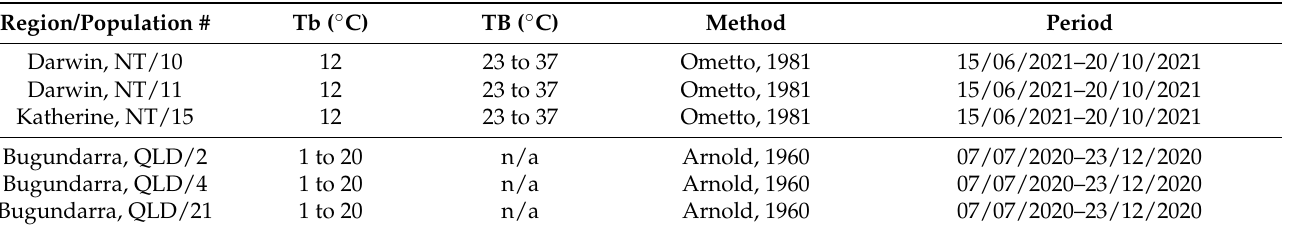
Table 4. Farm locations and range of temperature values used for Tb or TB in Tb/TB optimization method. n/a is not applicable. Population # refers to numbering in Table